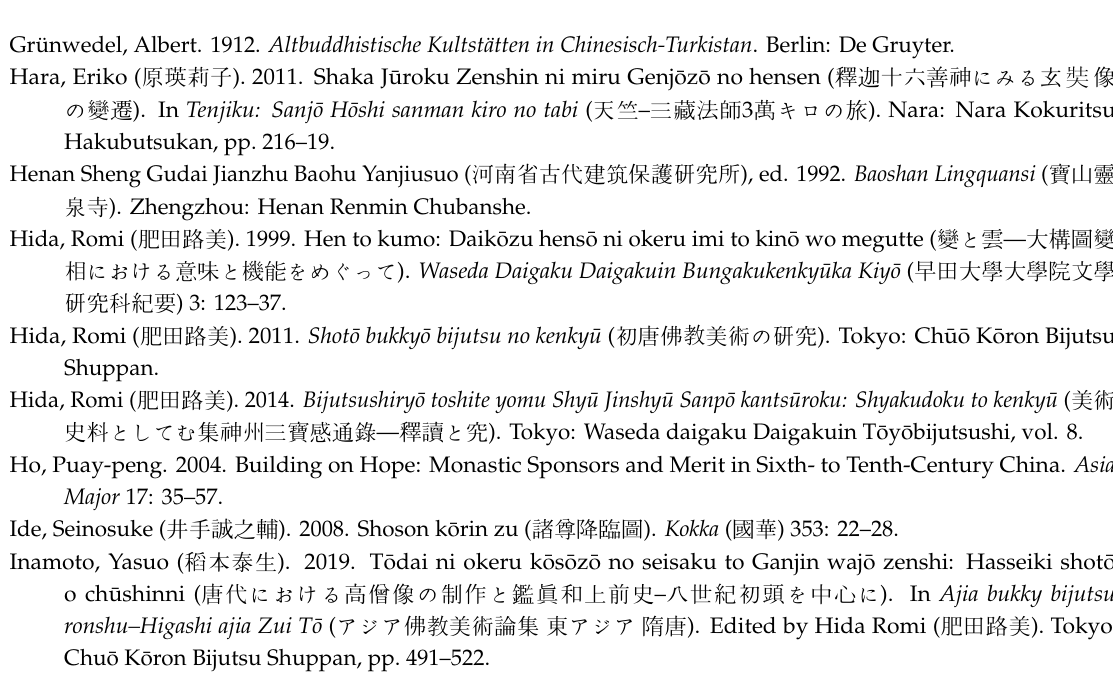
Figure 1. Itinerant Monk . Dunhuang, 10th century . Ink and colors on paper, 49.8 × 28.6 cm . National Museum of Korea.